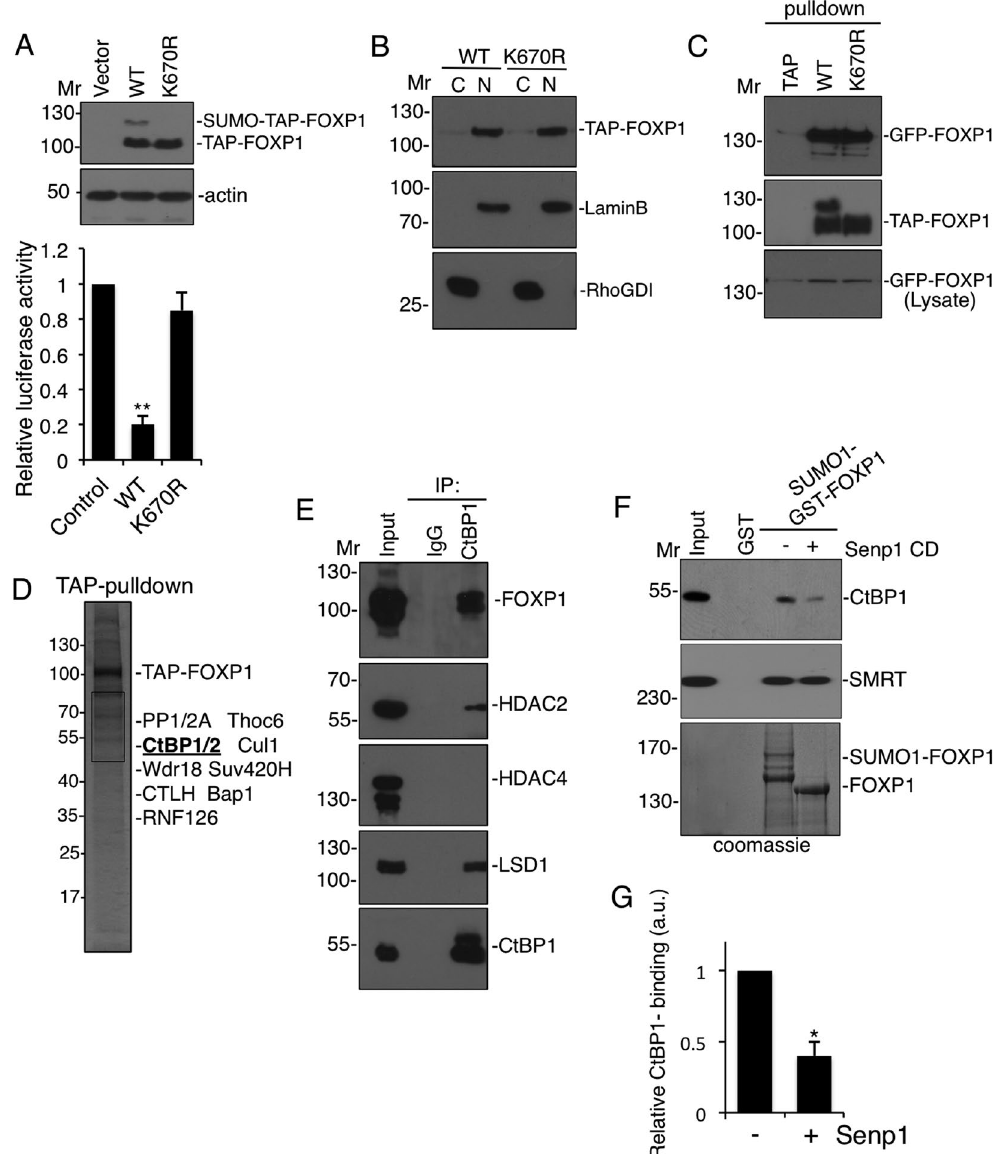
Figure 2. SUMOylation of FOXP1 regulates transcriptional repression and co-repressor binding. ( A ) SV40- driven luciferase was transfected into HEK293T cells along with either empty TAP vector, TAP-FOXP1-WT or TAP-FOXP1-K670R. Firefly luciferase activities were measured and normalised to Renilla lucifierease 48 hrs after transfection. Student’s t-test, n = 4, ** p < 0.01 Note equal expression of TAP-tagged WT or K670R mutant in HEK293T cells (upper panels). ( B ) HEK293T cells were transfected with either TAP-FOXP1-WT or TAP-FOXP1-K670R, fractionated into cytosolic ( C ) or nuclear fractions (N) and immunoblotted. No differences were observed indicating that SUMOylation does not regulate nuclear localisation of FOXP1. ( C ) Empty TAP vector, TAP-FOXP1-WT or TAP-FOXP1-K670R were cotransfected into HEK293T cells with GFP- FOXP1. The cells were lysed, TAP-FOXP1 variants precipitated with strepavidin beads, and immunoblotted revealing that SUMOylation does not affect FOXP1-dimerization. Lower panel shows equal expression levels of GFP-WT-FOXP1 across conditions. ( D ) TAP-FOXP1 was expressed in HEK293T cells, precipitated using strepavidin beads and resolved by SDS-PAGE followed by silver staining. Gel slices containing novel bands compared to control empty vector pulldowns (not shown), were trypsinised and proteins identified using Orbitrap mass spectrometery. ( E ) Cortical neuronal cultures (DIV 7) were lysed and immunoprecipitated with anti-Ctbp1 antibodies before being resolved using SDS-PAGE and immunoblotted as indicated. ( F ) SUMOylation of FOXP1 modulates Ctbp1 corepressor binding. Bacterially-purified SUMOylated GST-FOXP1 was bound to glutathione sepharose beads in the presence or absence of the Senp1-catalytic domain to mediate deSUMOylation. DeSUMOylated GST-FOXP1 is observed as a single band in the lower panel at around 130 KDa compared to the larger SUMOylated GST-FOXP1 bands (Lower panel). The beads were then incubated with lysates from cultured cortical neurons. Samples were resolved by SDS-PAGE and blotted for Ctbp1 or SMRT. ( G ) Quantification of (F) is shown as relative Ctbp1 binding to FOXP1. Student’s t-test, n = 3, * p <